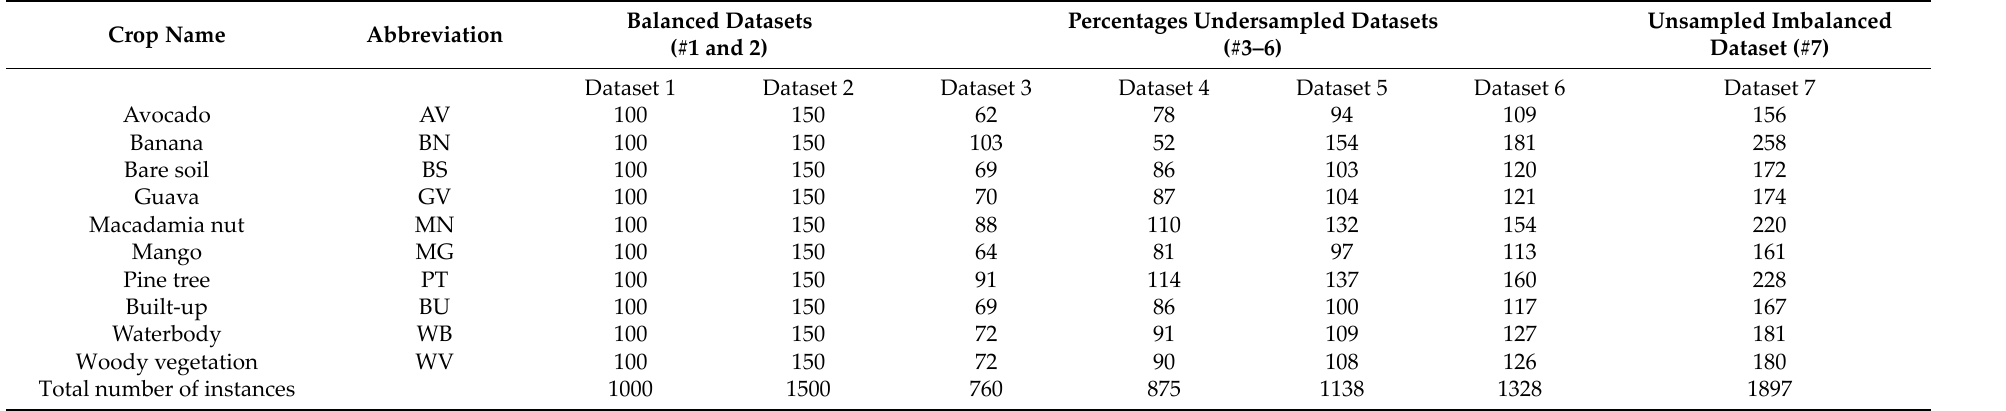
Table 2. List of fruit‑tree crops and co‑existing land‑use types and the descriptive statistics of the undersampled and original datasets. The # stands for the number of the datasets used in this